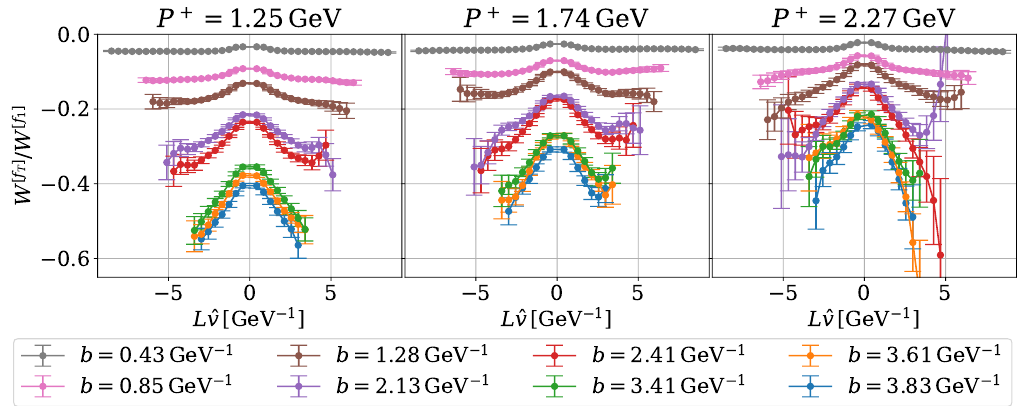
for different values of P + . The twist-three TMD f f 1 ( P + ; L ˆ v,b ) ¯ qγ ν q T